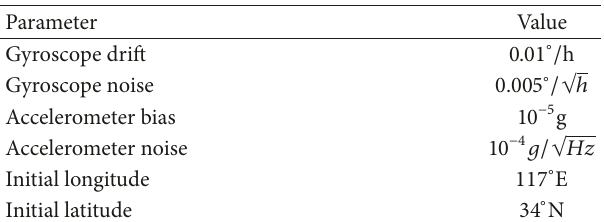
Table 2: Initial